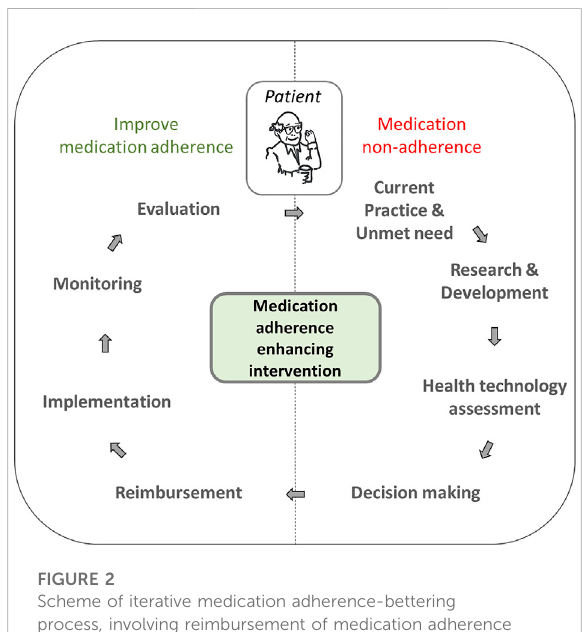
FIGURE 2 Scheme of iterative medication adherence-bettering process, involving reimbursement of medication adherence enhancing